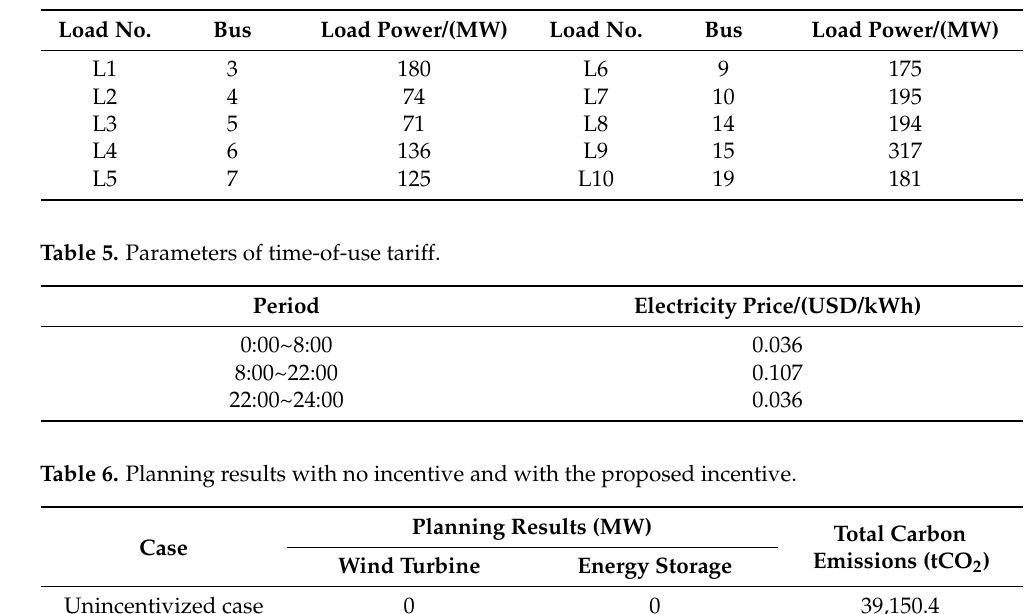
Table 4. Power load reference value.